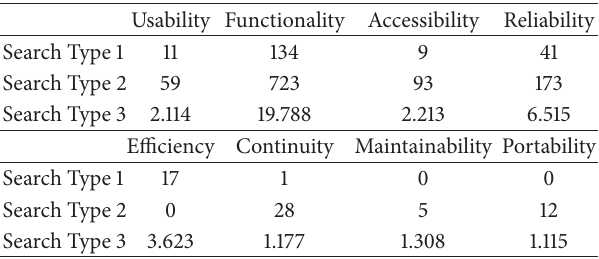
Table 2: Number of results of Search Types 1, 2, and 3, respectively, for Quality